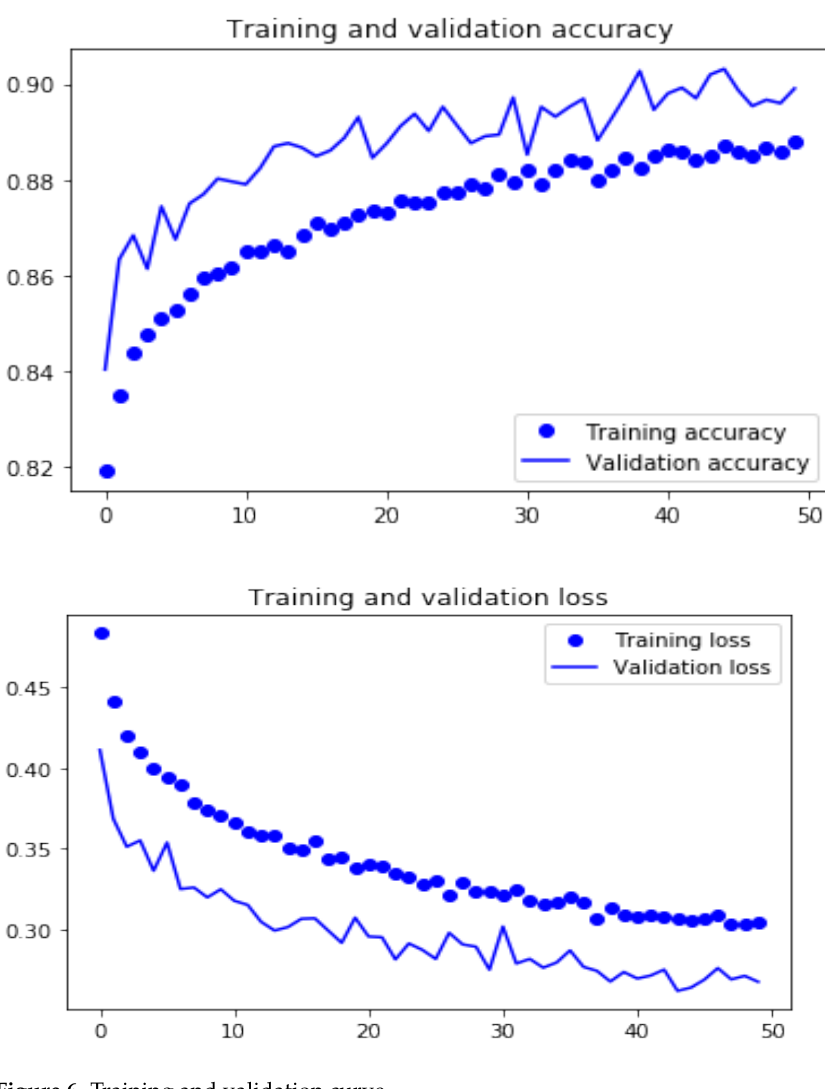
Figure 6. Training and validation curve.